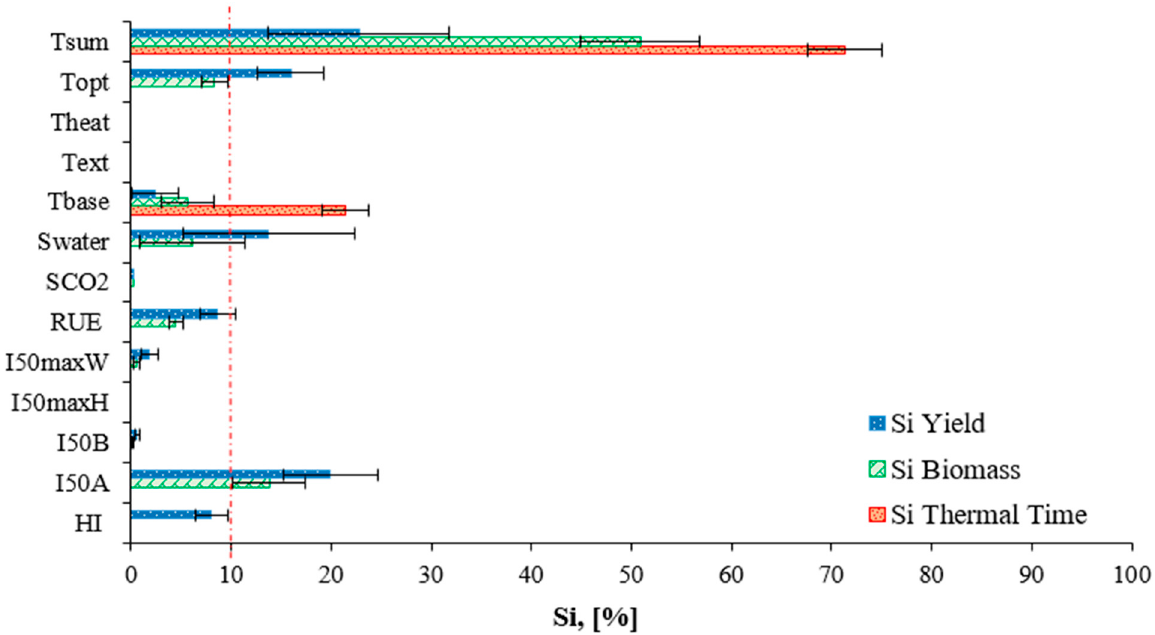
Figure 6. First order sensitivity indices (±standard deviation) with Sobol’s method for the rainfed bean crop for the variables predicted by the SIMPLE model; dashed line denotes 10% threshold.